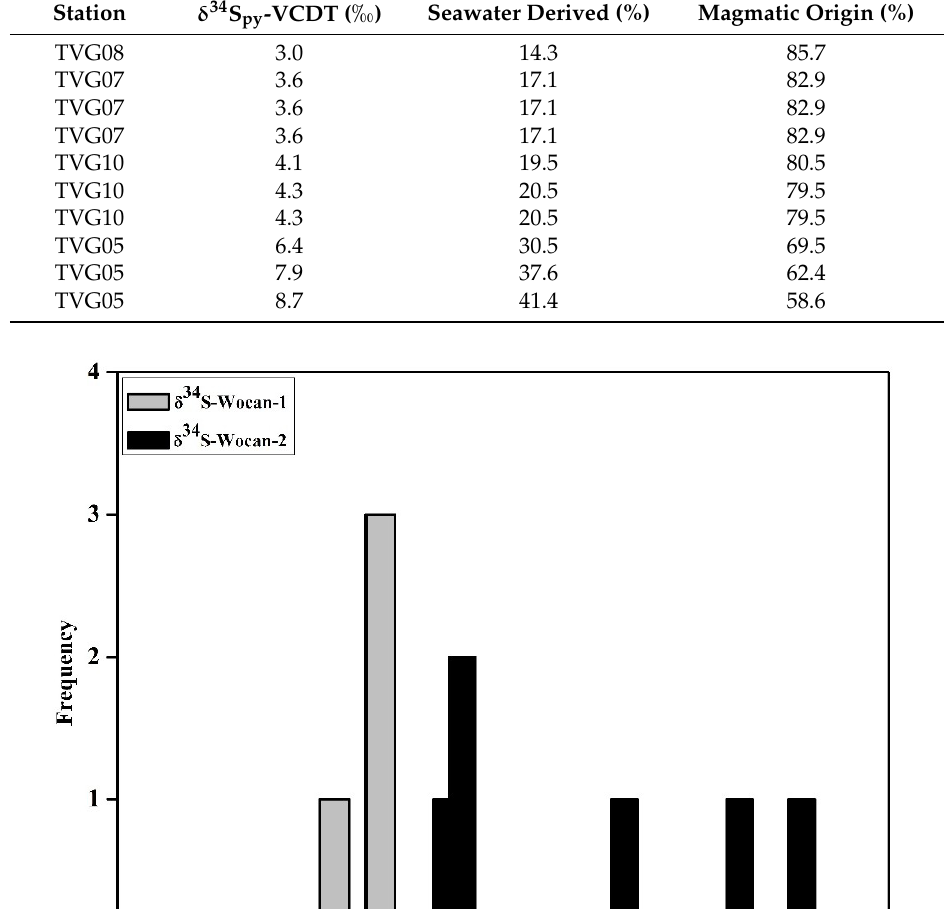
Figure 3. Frequency histogram for δ 34 S ‰ of Wocan-1 and Wocan-2 sediments.